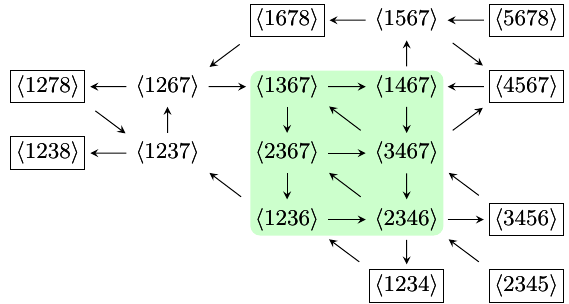
Figure 19. The cluster obtained after (cid:12)ve cyclic mutations of (cid:12)gure 18 in the (cid:12)rst two columns.